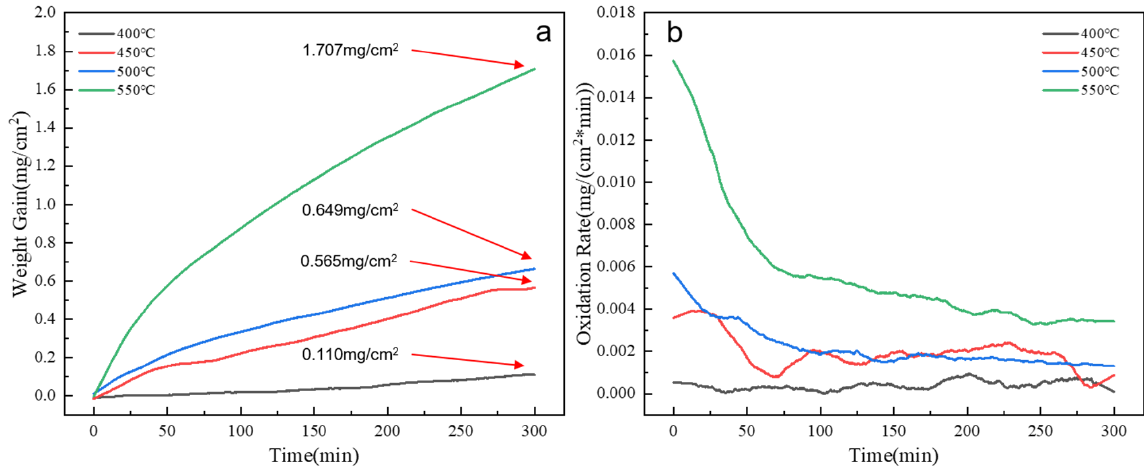
Figure 3. ( a )The weight gain curve of Al–2Li alloy exposed for 5 h; ( b )The weight gain rate curve of Figure 3. ( a ) The weight gain curve of Al–2Li alloy exposed for 5 h; ( b ) The weight gain rate curve of Al–2Li alloy exposed for 5 h. Al–2Li alloy exposed for 5